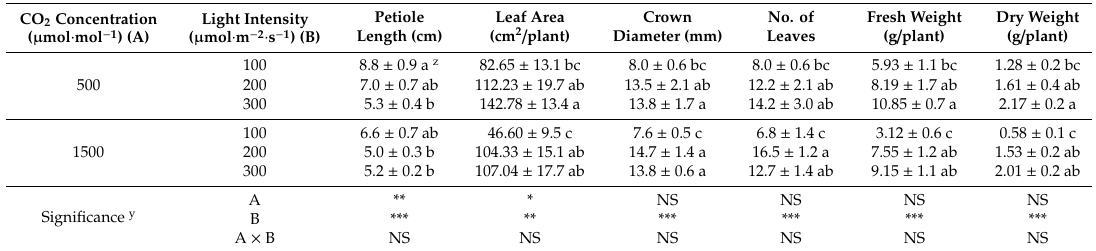
significant at p ≤ 0.05, 0.01, or 0.001,